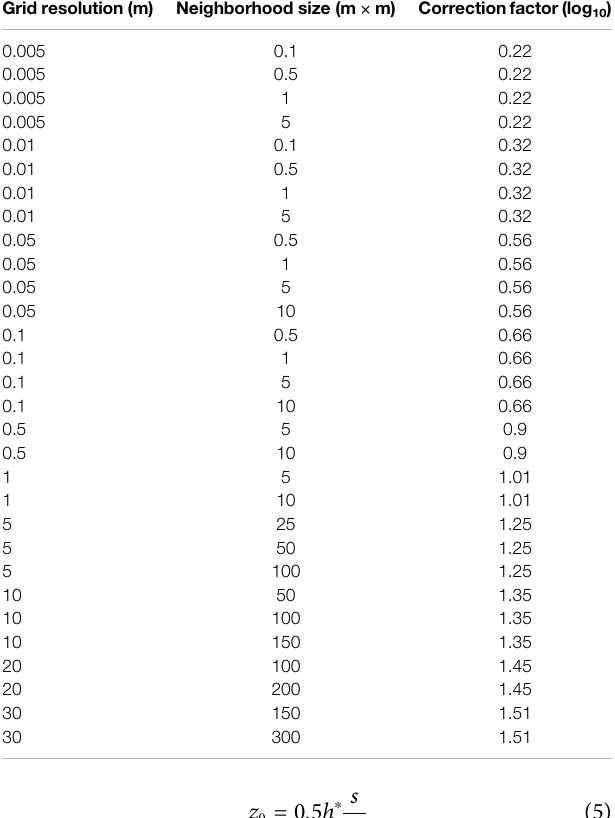
TABLE 3 | Index of correction factors for each grid resolution.